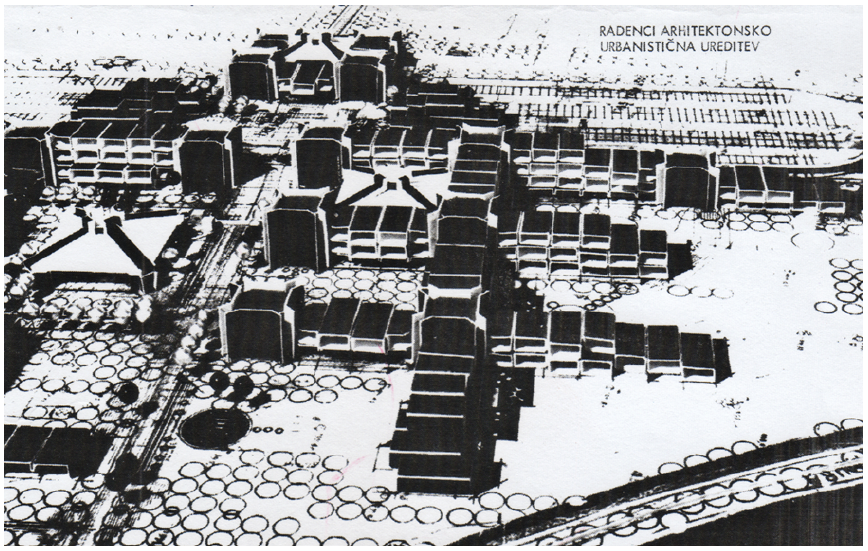
Fig. 1 Franc Avbelj, Urban and Archi- tectural Project for Radenci Spa (1967), photography of model (Source: Private archive of architect Franc Avbelj in Ljubljana,